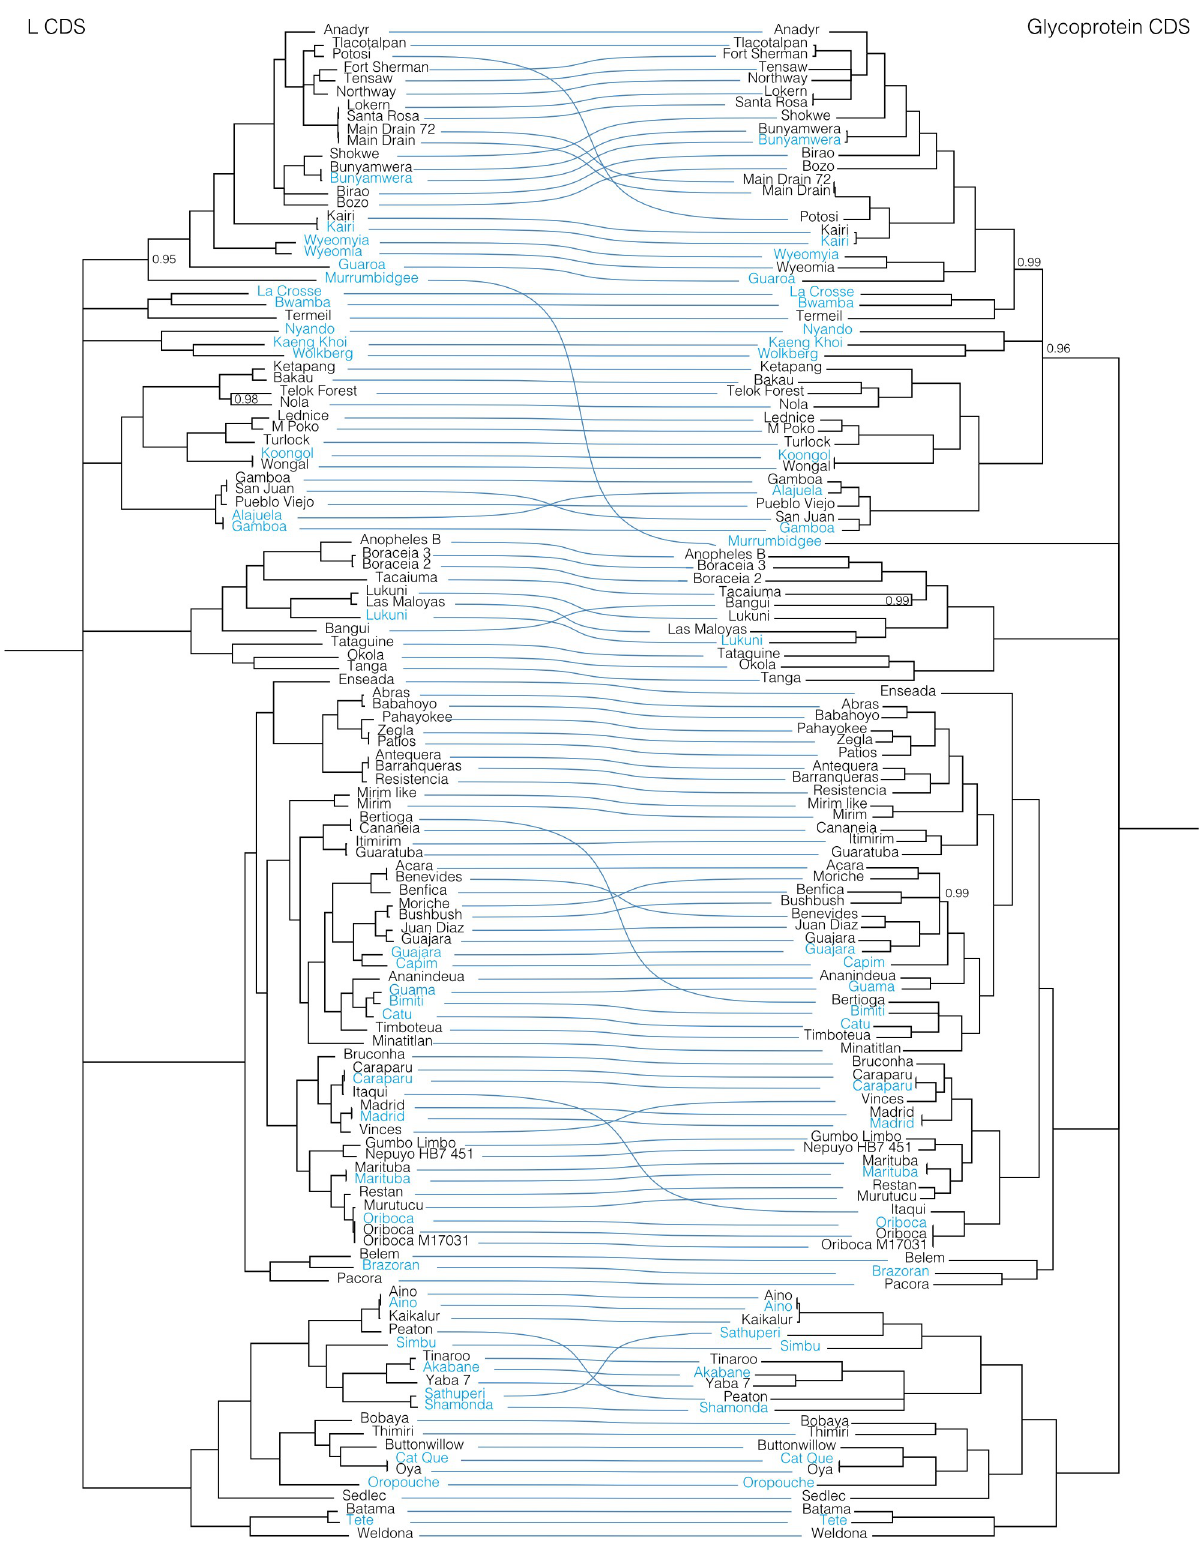
Fig 8. Co-phylogenies of Orthobunyavirus L and M segment trees. Branches with support values < 0.95 were converted to polytomies. All other branch support values were 1 unless indicated. Trees were rooted with outgroups as in Figs 2–4.